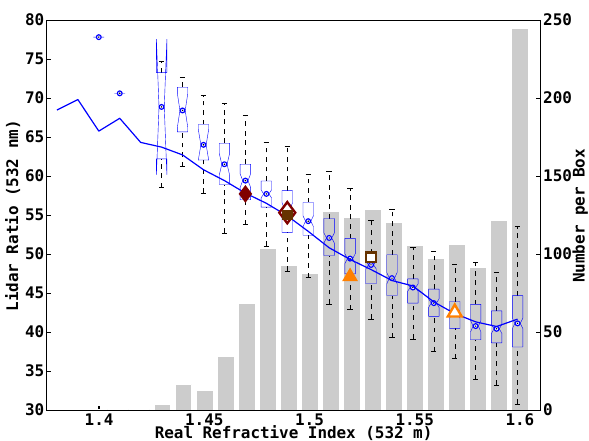
Fig. 9. Lidar ratio is highly anti-correlated with the real refractive index of dust, as shown here for all the AERONET sites of Table 4. Boxplots represent all data with depolarizations greater than 0.2 and fine volume fractions less than 0.05. Median lidar ratios are the tar- gets at the center of the boxes, and the borders of the whiskers and boxes represent the 1, 25, 75, and 99 percentiles; gray bars indicate the number of data points for each box. The solid line is the median for all data with depolarizations greater than 0.2 and all fine volume fractions. Symbols represent regional medians for non-Sahel Africa (diamonds), African Sahel (squares), and the Middle East (triangles). Open symbols are restricted to fine volume fractions less than 0.05.